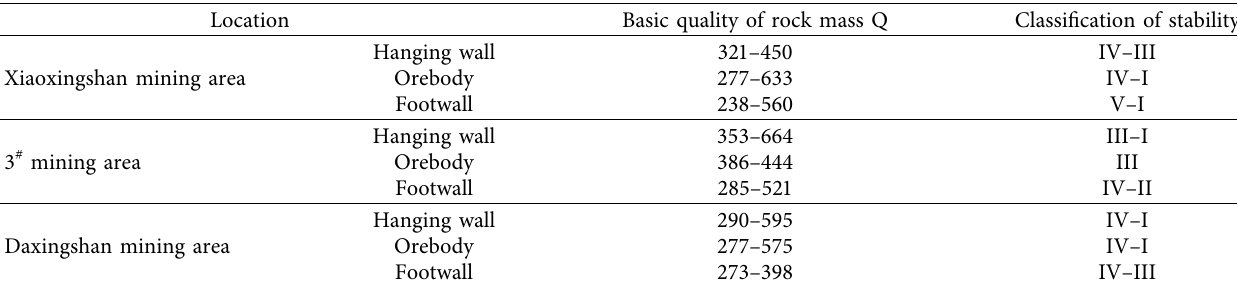
Figure 3: Rock mass quality classification test. (a) Point load test sample, (b) sample after test, (c) pole contour map of Xiaoxingshan footwall, (d) pole contour map of Daxingshan orebody, and (e) pole contour map of 3 # mining area hanging wall. Table 1: Ore-rock stability classification of Xingshan iron mine.